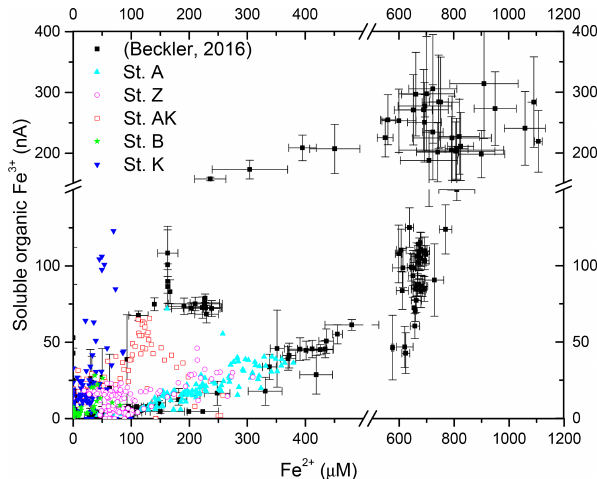
Figure 7. Current intensities of organic-Fe(III) complexes as a func- tion of Fe 2 + concentrations measured at each depth at stations A, Z, AK, B and K compared to the same data obtained from iron-rich deep-sea sediments (Beckler et al.,